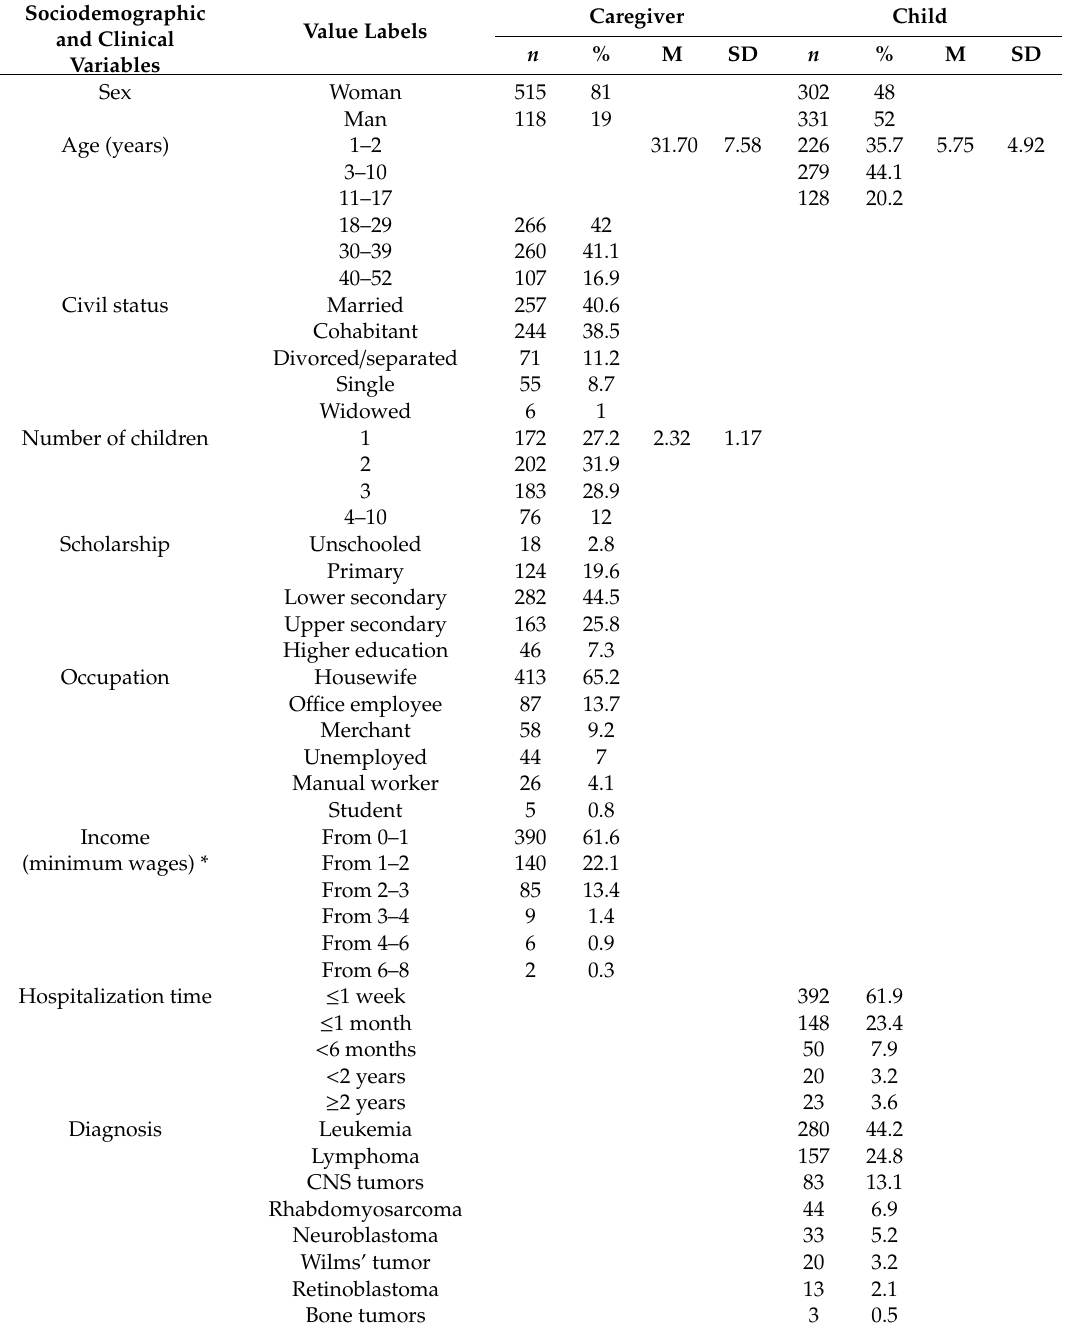
Table 1. Summary statistics of sociodemographic and clinical